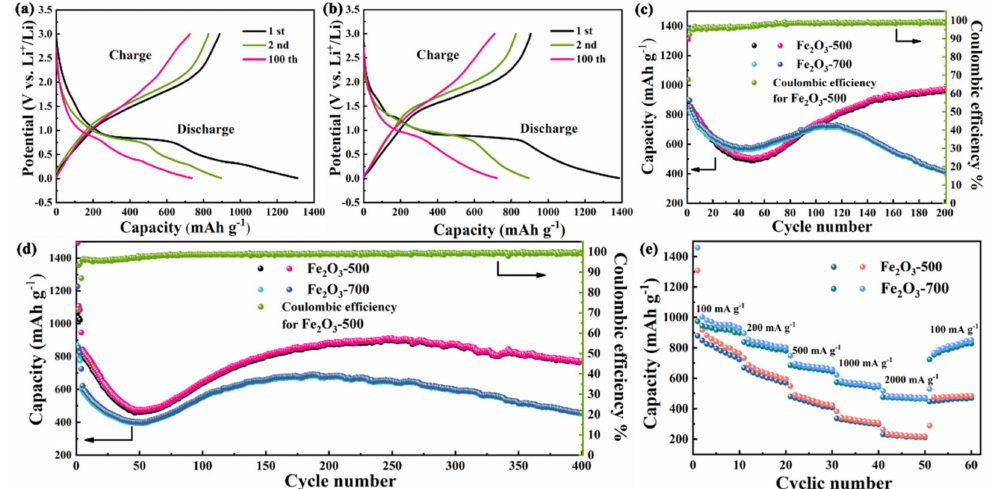
Figure 4. Discharge/charge profiles of ( a ) Fe 2 O 3 -500 and ( b ) Fe 2 O 3 -700 for the 1st, 2nd, 100th cycles. ( c ) Cycling performance of Fe 2 O 3 . ( d ) Long-cycling performance of Fe 2 O 3 . ( e ) Rate capability of Fe 2 O 3